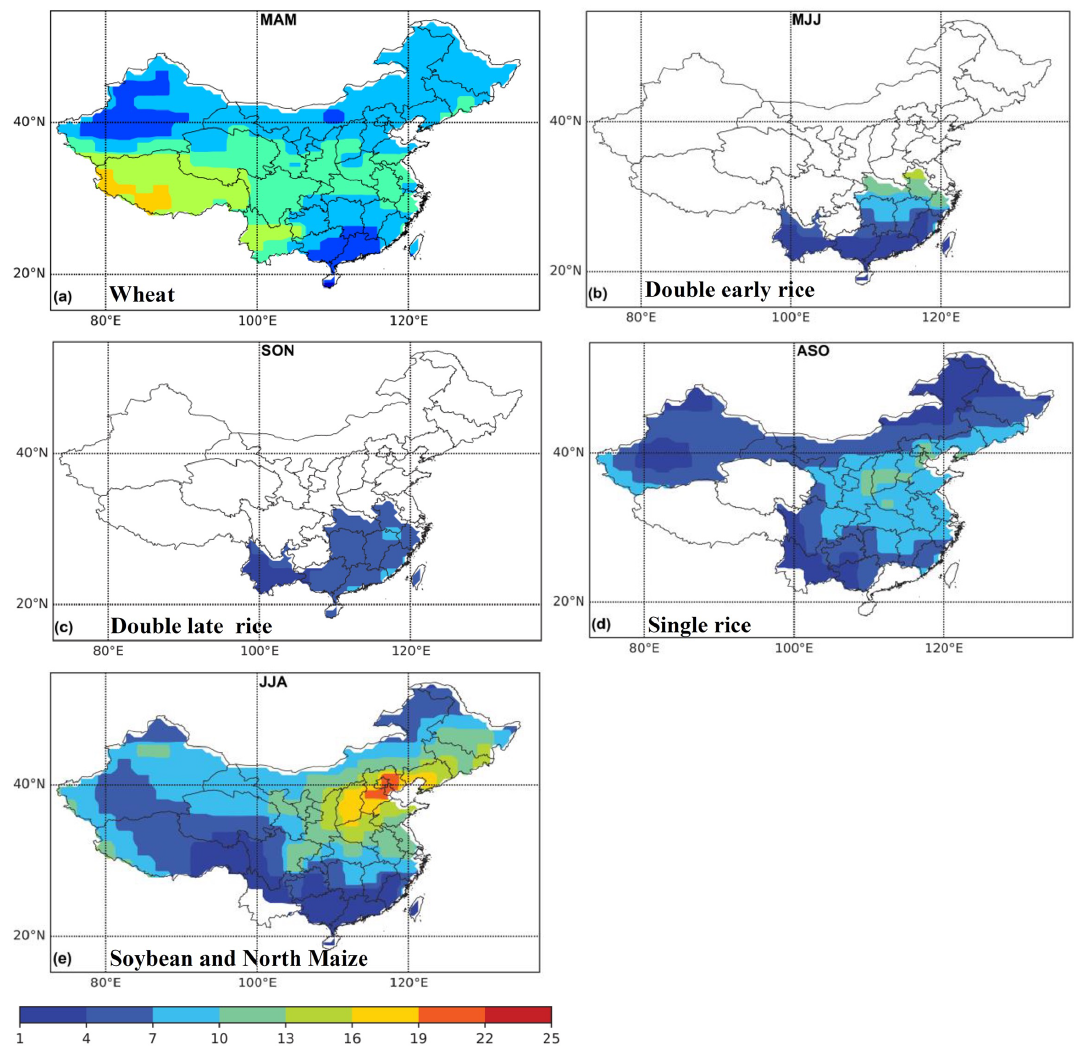
Figure 3. The spatial distribution of 8-year average growing season accumulated AOT40 for (a) wheat, (b) double early rice, (c) double late rice, (d) single rice and south maize, and (e) soybean and north maize. The unit is